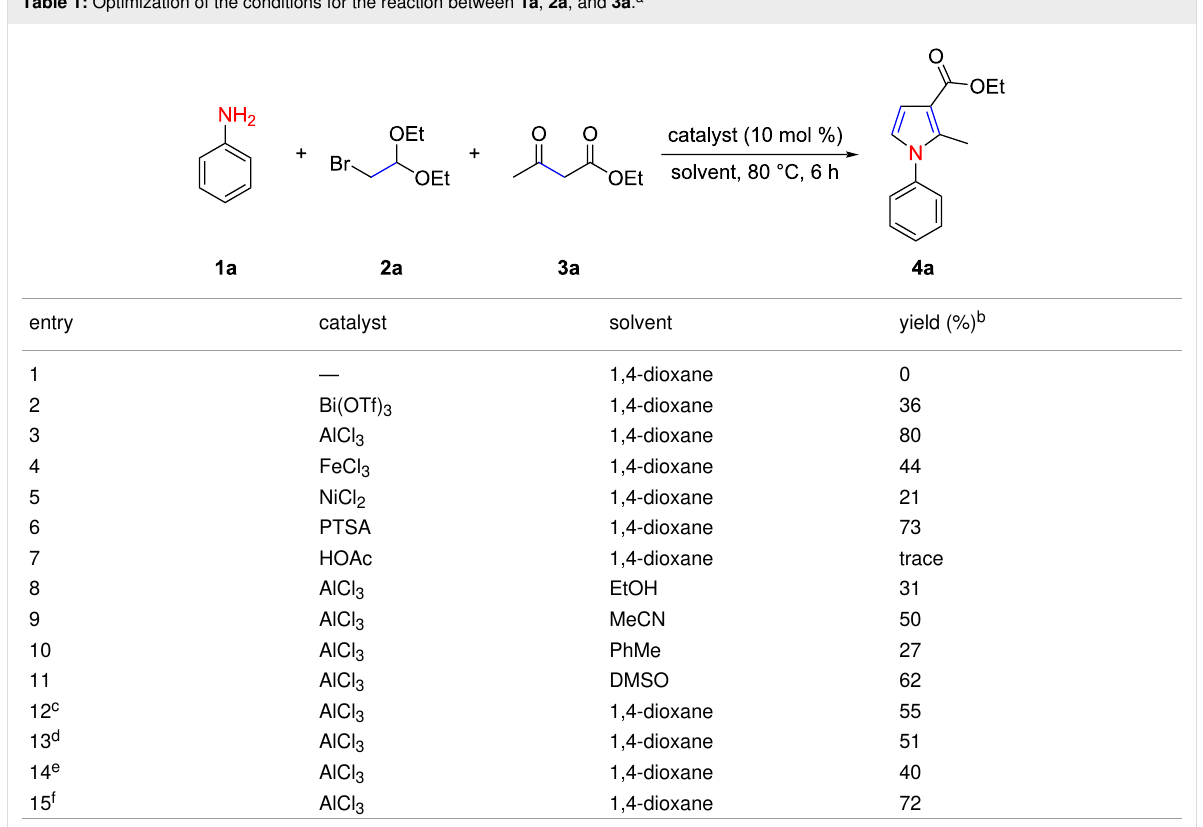
Table 1: Optimization of the conditions for the reaction between 1a , 2a , and 3a .